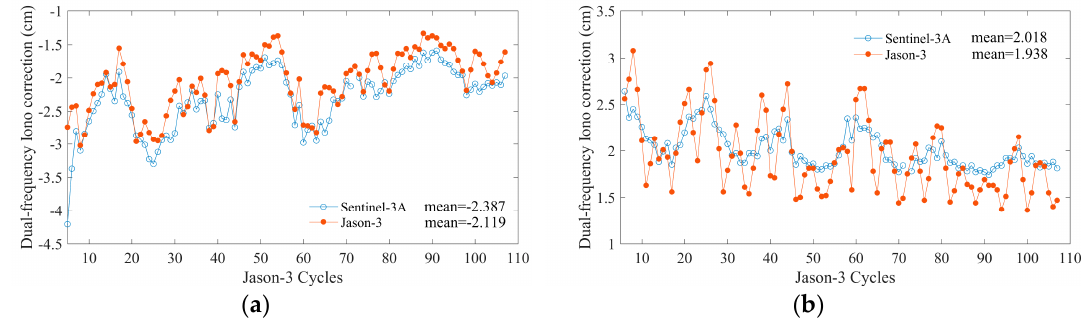
Figure 24. Comparison of cycle by cycle ( a ) means and ( b ) standard deviations of dual frequency ionospheric corrections between Sentinel-3A and Jason-3 according to Jason-3 repeat cycles.